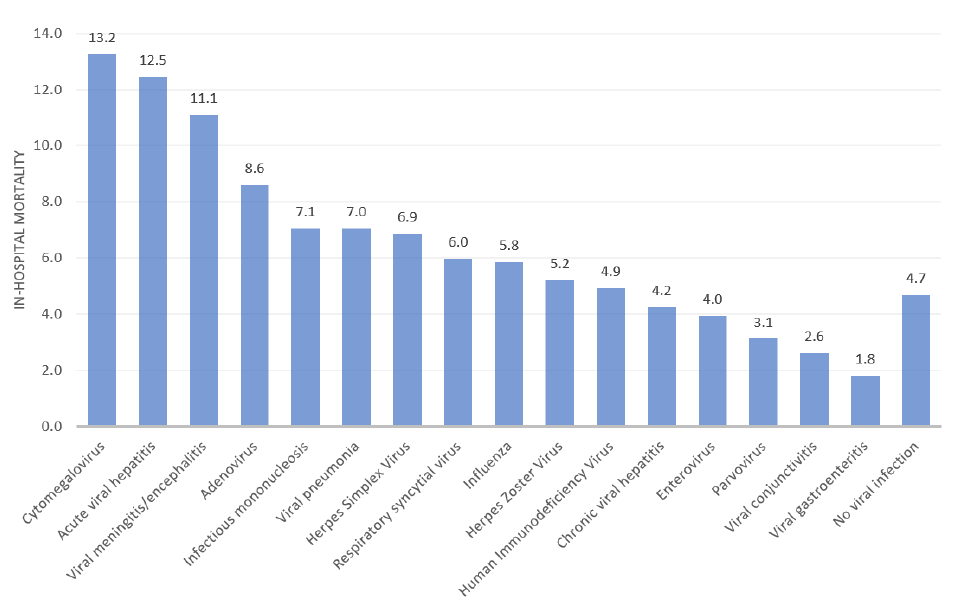
Figure 2. In ‐ hospital mortality rate for records with a diagnosis of heart failure and viral infection. The adjusted odds for in ‐ hospital mortality for viral infection diagnoses compared to records without a diagnosis of viral infection are shown in Figure 3. The three viral infec ‐ tions most significantly associated with increased odds of mortality were cytomegalovirus infection (OR 1.85 95% CI 1.58–2.17), acute hepatitis (OR 1.29 95% CI 1.15–1.45), and HIV (OR 1.22 95% CI 1.11–1.34). There was significantly reduced odds of mortality compared to no infection for influenza (OR 0.81 95% CI 0.77–0.84), viral pneumonia (OR 0.80 95% CI 0.74–0.84), and viral gastroenteritis (OR 0.54 95% CI 0.47–0.62). The variables in the model for any viral infection vs. no viral infection with the great ‐ est odds of mortality were intubation (OR 7.34 95%CI 7.24–7.44, p < 0.001), liver failure (OR 5.19 95%CI 5.08–5.31, p < 0.001), and respiratory failure or arrest (OR 4.60 95%CI 4.54– 4.65, p < 0.001). The impact of the intubation (34.0% vs. 3.4%), liver failure (28.4% vs. 4.3%), and respiratory failure or arrest (11.2% vs. 1.9%) variables had a much higher mortality rate compared to records that did not have the variables. When the cohort was restricted to patients who were over the age of 80 years, only acute viral hepatitis was associated with increased in ‐ hospital mortality (Figure A2).